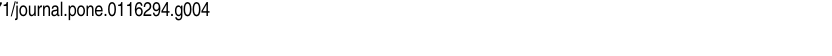
Fig. 4. Scanning electron microscopy image of SU10 five minutes after adding them to the bacterial culture. Empty phage particles can be seen adsorbed onto the surface of the host